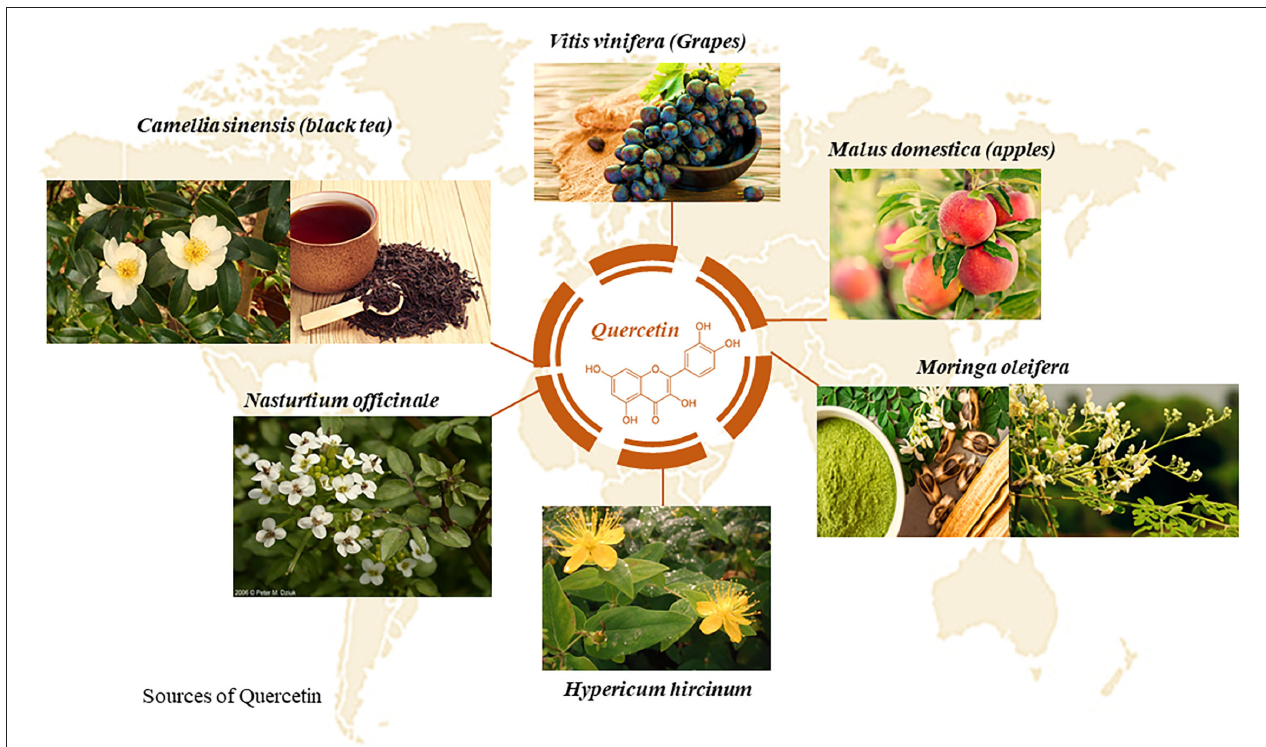
FIGURE 6 | Plant sources of quercetin, a bioflavonoid with numerous medicinal